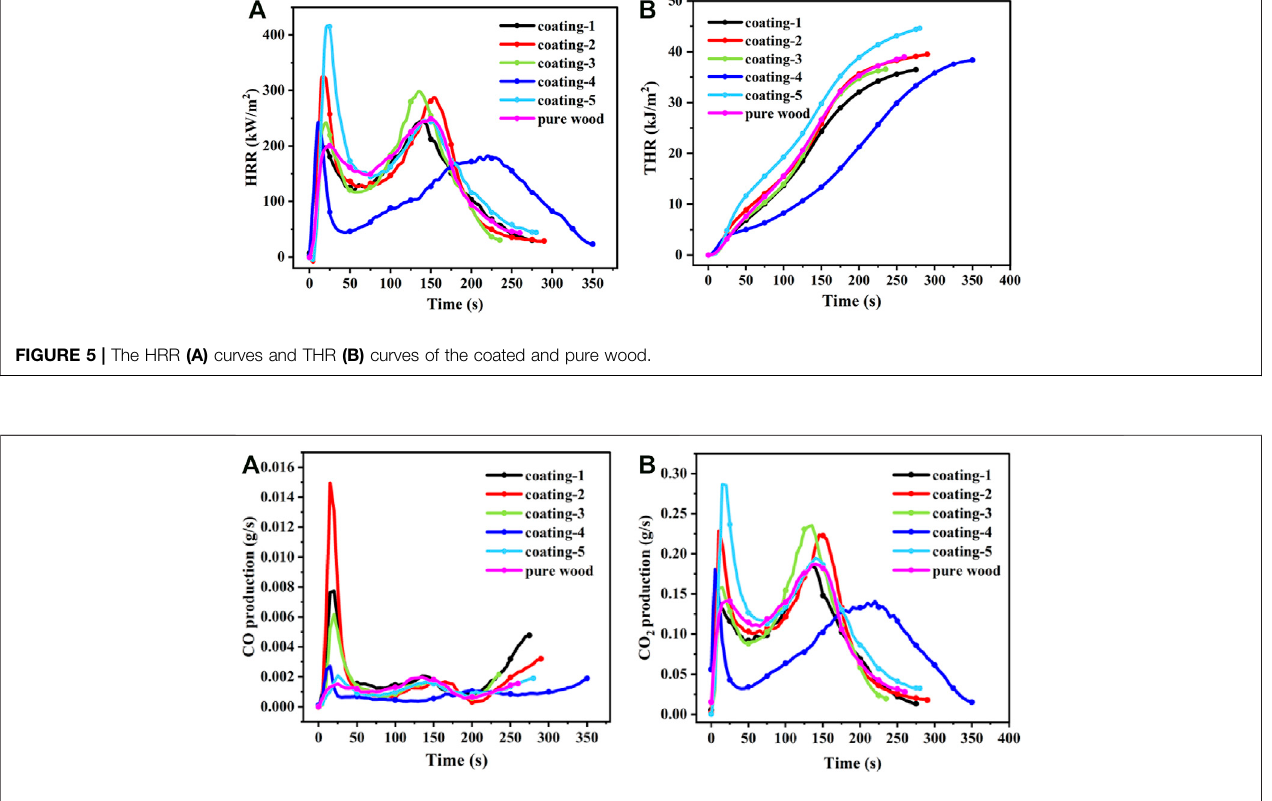
FIGURE 6 | CO 2 (A) and CO (B) production